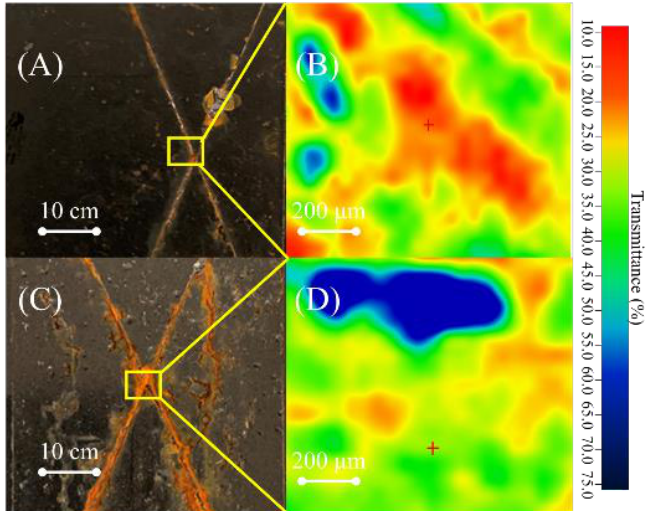
Figure 10. ( A ) Optical micrograph of the scratched crevice coating after 480 h of the salt spray of CS/PMAA-MSNs@GO loading TA coating and ( B ) FT-IR mapping test by the FT-IR microscope; ( C ) optical micrograph of CS/PMAA-MSNs@GO coating without TA and ( D ) FT-IR mapping.